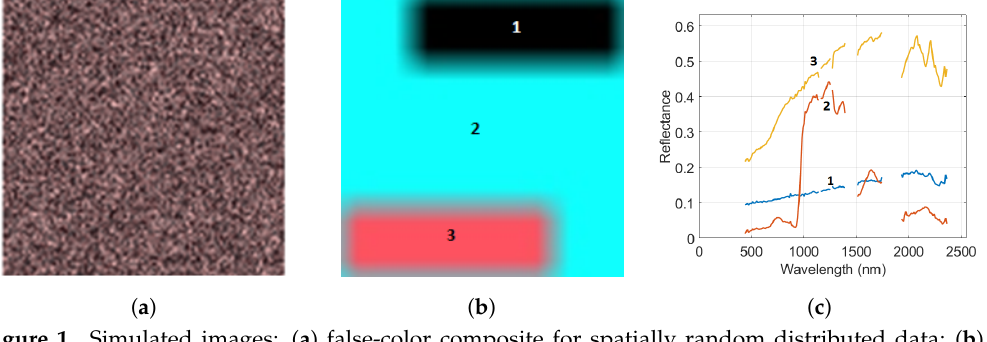
Figure 1. Simulated images: ( a ) false-color composite for spatially random distributed data; ( b ) false-color composite of image with spatial structure; ( c ) endmembers used in the simulated images.